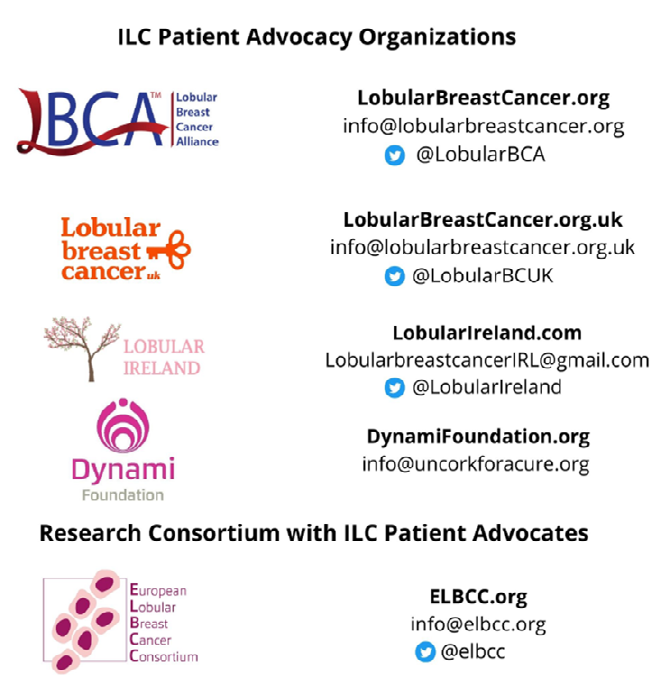
Figure 1. Lobular Breast Cancer Patient Advocacy Entities. Researchers, clinicians and advocates interested in getting involved in organizational activities or lobular patient advocacy can contact these organizations to learn more.